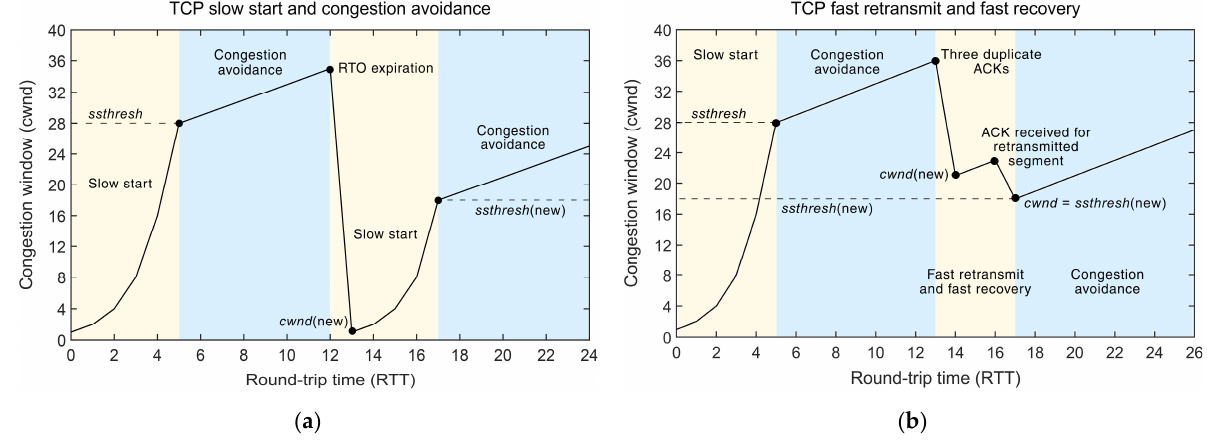
Figure 3. Standard working principles of the TCP CC mechanism related to the interdependence between cwnd and RTT for: ( a ) the TCP slow start and congestion avoidance mechanism; ( b ) the TCP fast retransmit and fast recovery mechanism.